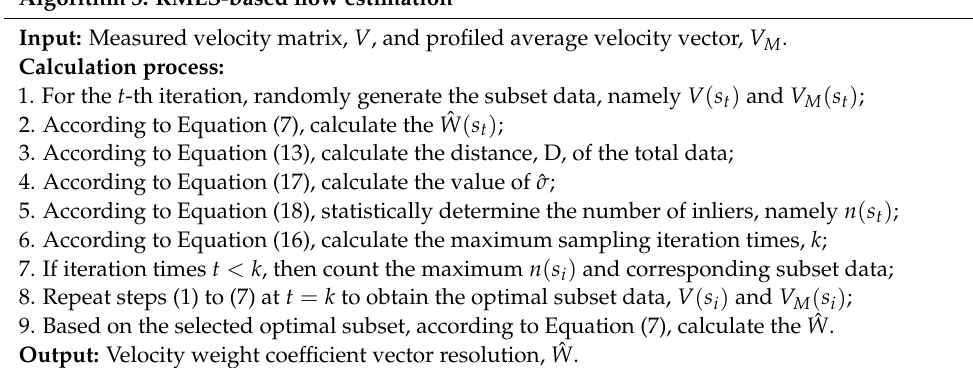
Algorithm 3: RMLS-based flow